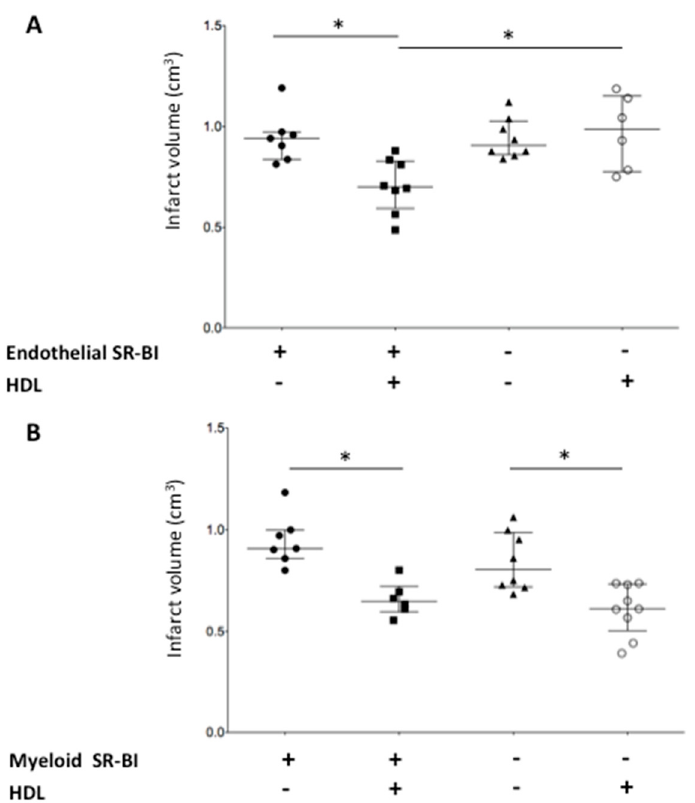
Figure 1. Role of endothelial SR-BI in the neuroprotective effects of HDLs in AIS. Infarct volume was assessed on coronal brain slices by TTC staining after a 4 h intraluminal occlusion of the middle cerebral artery followed by 20 h of reperfusion. ( A ) In SR-BI flox/flox mice, intracarotid infusion of HDLs limited the infarct volume by 25% relative to saline-injected mice (* p < 0.05). The neuropro- tective effects of HDLs were thwarted by the deletion of endothelial SR-BI in SR-BI flox/flox /Tie2-Cre (* p < 0.05). ( B ) The neuroprotective effects of HDLs were not mediated by the expression of SR-BI in myeloid cells. In SR-BI flox/flox mice, intracarotid infusion of HDLs limited the infarct volume by 28% compared to saline infusion (* p < 0.05). The neuroprotective effects of HDLs were maintained despite the deletion of myeloid SR-BI in SR-BI flox/flox /LysM-Cre mice (* p < 0.05).